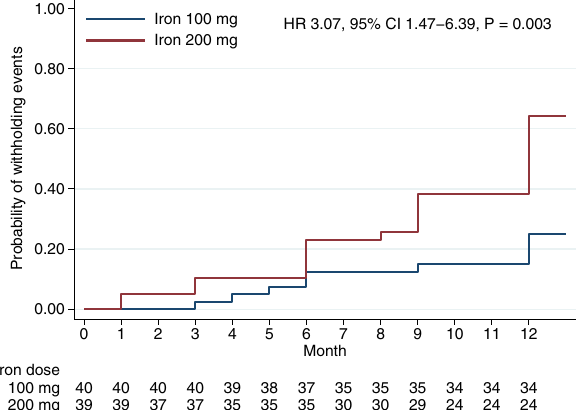
Figure 3. Cumulative incidences of the first withholding intravenous iron events by months.